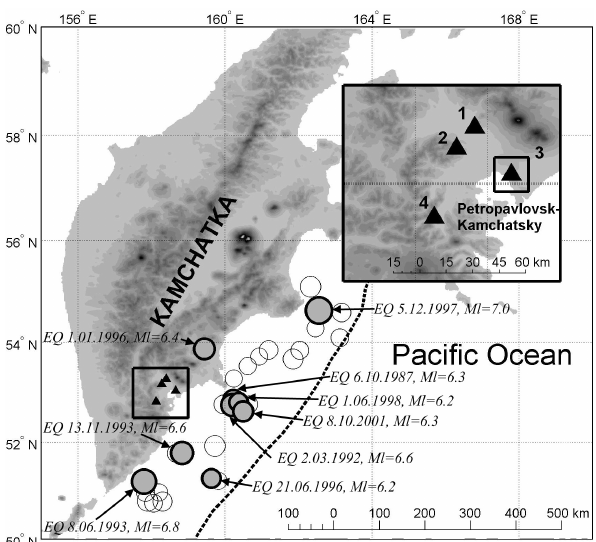
Fig. 1. Schematic of the measurement area (small rectangular frame on the left) and epicenters of largest earthquakes ( M l ≥ 6, H ≤ 50km, D ≤ 350km) from 1985 to 2009, where M l – local earthquake magnitude, H – depth, D – distance from the epicenter. The large frame on the right shows a zoomed-in view of the positions of hydrogeological stations: 1 – Pinachevo, 2 – Moroznaya, 3 – Khlebozavod, 4 – Verkhnyaya Paratunka. The solid circles denote the earthquakes reportedly preceded by hydrogeochemical anomalies. The dashed line is the axis of the deep-sea trench. The earthquakes were selected using the catalog of Kamchatka Branch, Geophysical Survey of Russian Academy of Sciences.